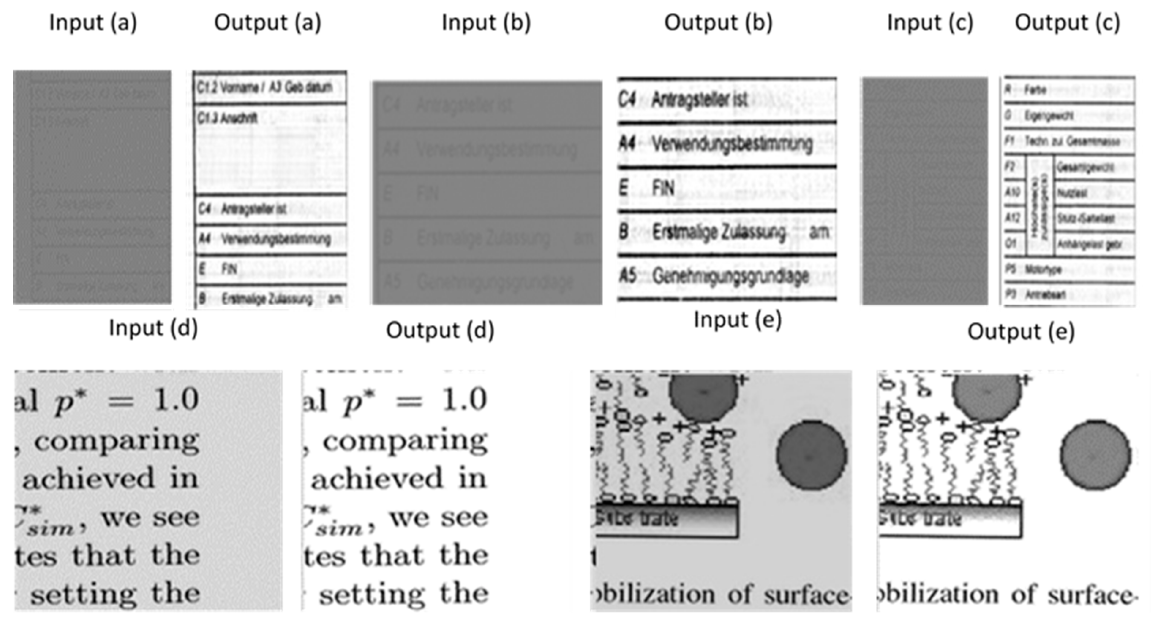
Appl. Sci. 2022 , 12 , 9601 Figure 10. Samples of contrast adjustments of natural document images with contrast distortion.